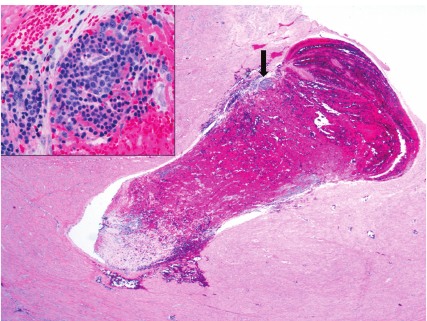
Figure 2: EMH within uterine thrombus, hematoxylin-eosin stain, magnification 100x (insert 400x).